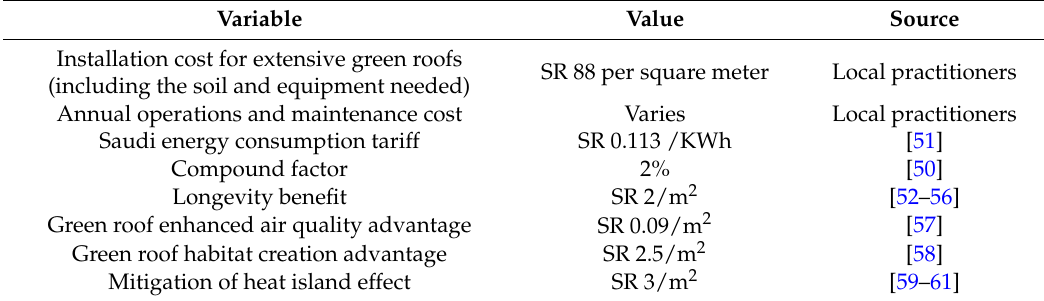
Table 4. Sources for net present value ( NPV) computation